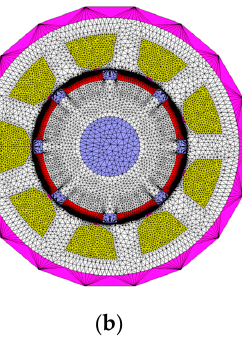
Table 3. Inductances by FEA.